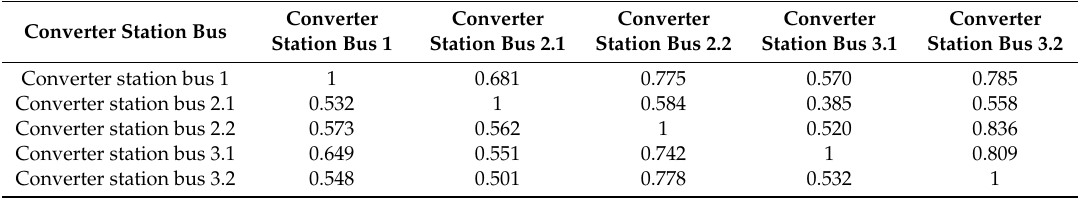
Table A2. The MIIF of converter station buses with Area 1 to be isolated.